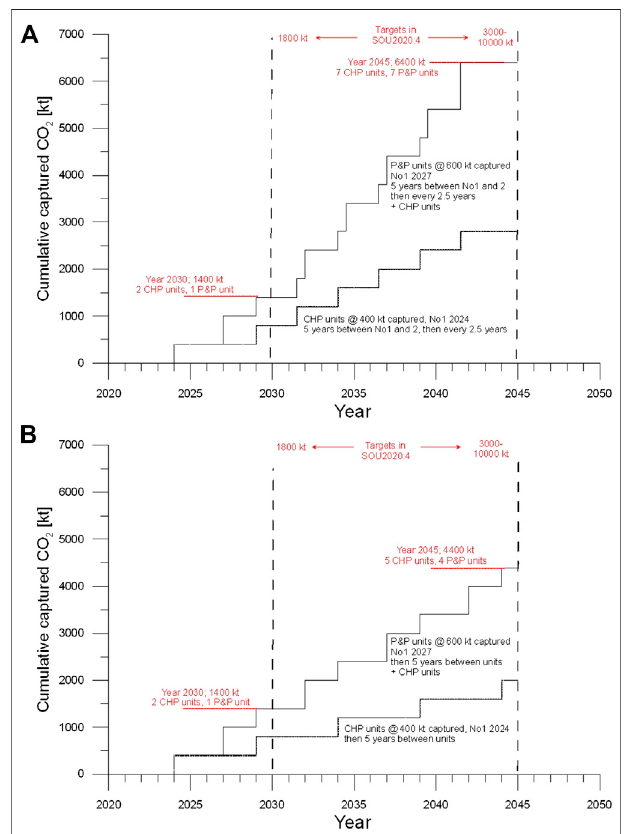
FIGURE 3 | Two schematic roadmaps for the development of full-scale BECCS projects in Sweden. These roadmaps assume the application of capture in P&P and CHP plants. The roadmaps apply the target values proposed in SOU (2020):4; 1.8 MtCO 2 captured is expected to result from the auctioning system by 2030, and the indicative target is to capture 3 – 10 MtCO 2 by 2045. (A) An optimistic scenario; (B) a less-optimistic